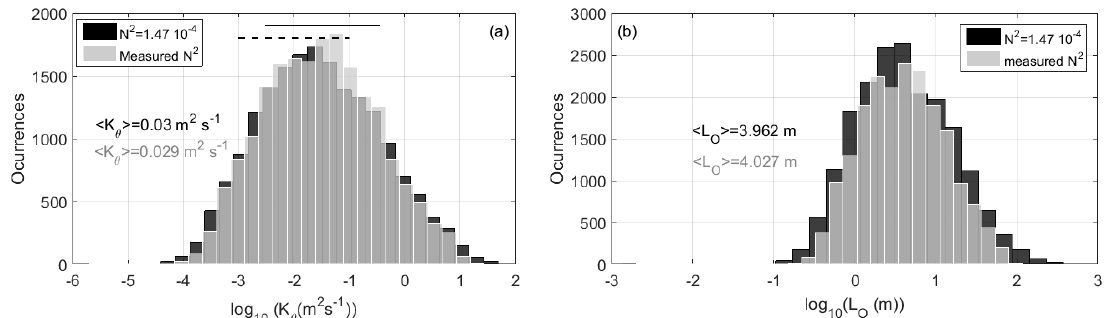
Figure 12. ( a ) Histogram of eddy di ff usivity log 10 ( K θ (m 2 s − 1 )) with measured N 2 (gray) and with N 2 = 1.47 10 − 4 rad 2 s − 2 (black). The solid and dashed horizontal segments are the observed ranges of values after Alisse and Sidi [29] and Bertin et al. [44] from high resolution balloon measurements for stratospheric heights. ( b ) Same as ( a ) for log 10 ( L O (m )) .